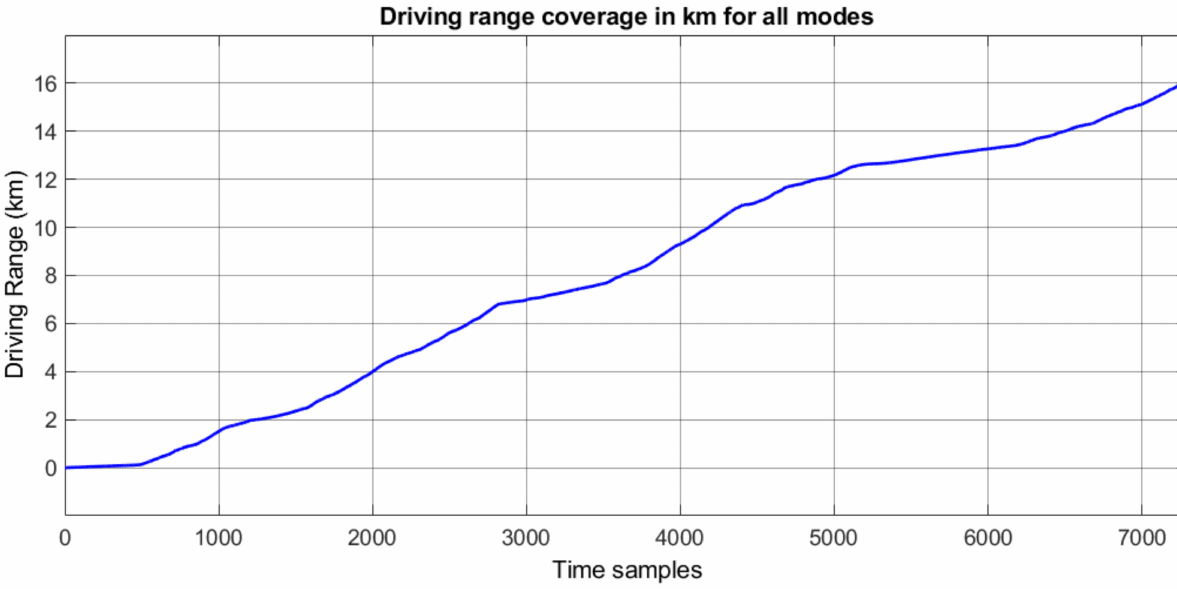
Figure 18. Simulation results for Driving range during HEV